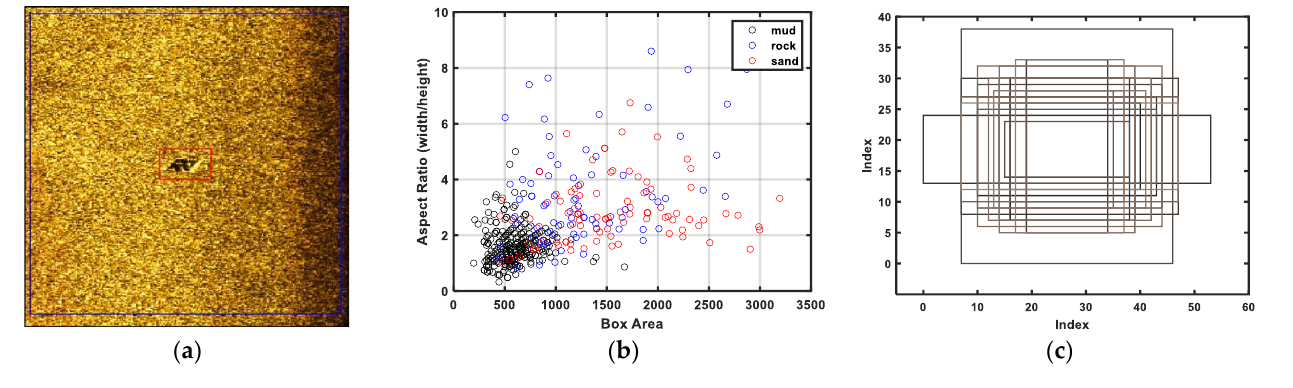
Figure 9. ( a ) Labeling example, ( b ) labeling result, and ( c ) anchor boxes applied to the network. The YOLO algorithm uses an anchor box to detect suspicious objects in images.